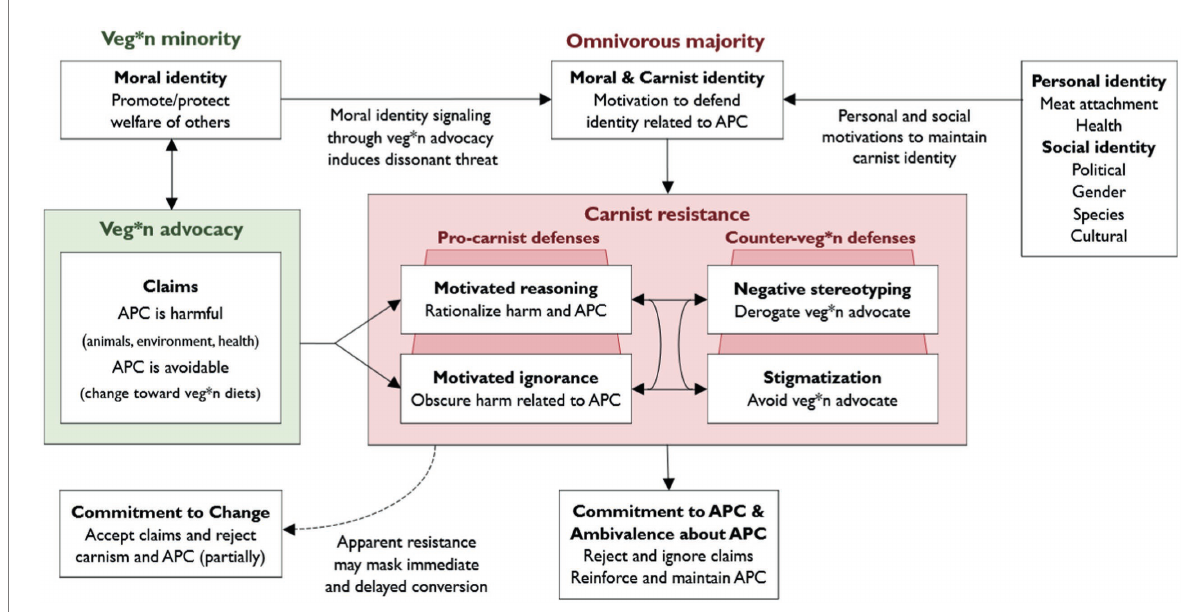
FIGURE 1 Identity-based Motivational Account of Carnist Resistance to Veg*n Advocacy. Veg*n minorities who engage in advocacy signal a moral identity by making claims that animal-product consumption (APC) is harmful and avoidable. This may evoke carnist resistance among the omnivirous majority, which may ultimately reinforce commitment to and ambivalence about APC. However, apparant resistance may mask immediate and delayed conversion (i.e., indirect and private acceptance of the advocates’ claims), priming commitment to behavioral change. We assume veg*n advocates’ primary claims consider the impact of APC on animal welfare, followed by concerns about environmental welfare and human health. Our account is explained in detail in the